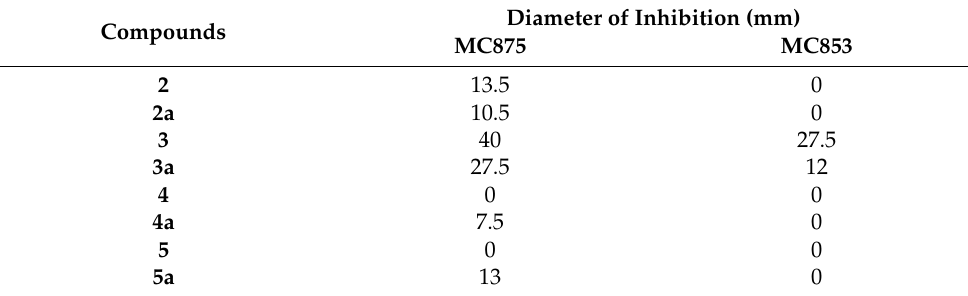
Table 2. Result of anti-micograms against the fungal strains (MC875 and